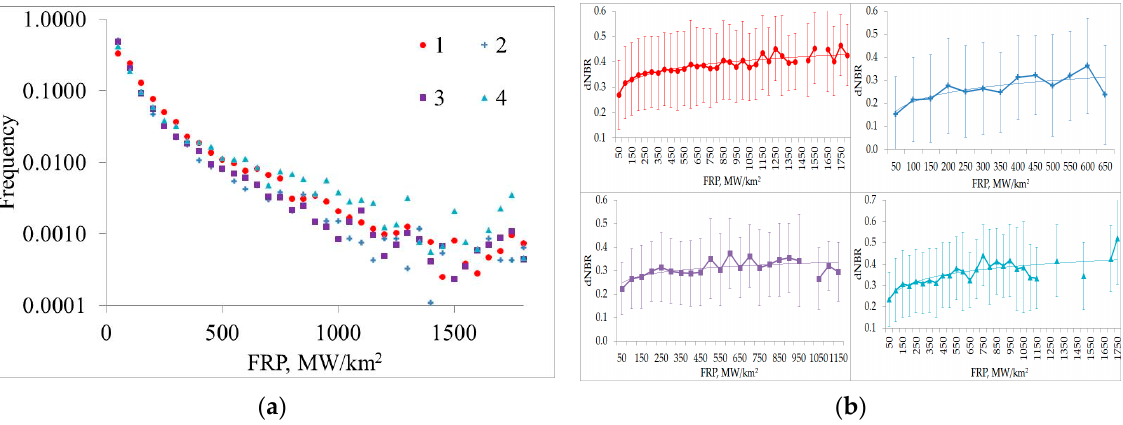
Figure 2. ( a ) Frequency distribution of fire pixels depending on their FRP. The numbers indicate different dominant tree stands: 1—larch forests (red circles); 2—deciduous forests (blue diamonds); 3—pine forests (purple squares); and 4—DNC forests (cyan triangles). ( b ) dNBR depending on the FRP. Color scheme is the same as for the left panel. Error bars correspond to one standard deviation. Each point shows the mean dNBR value for the corresponding FRP interval. Points are shown only for FRP intervals with 50 fire pixels or more.